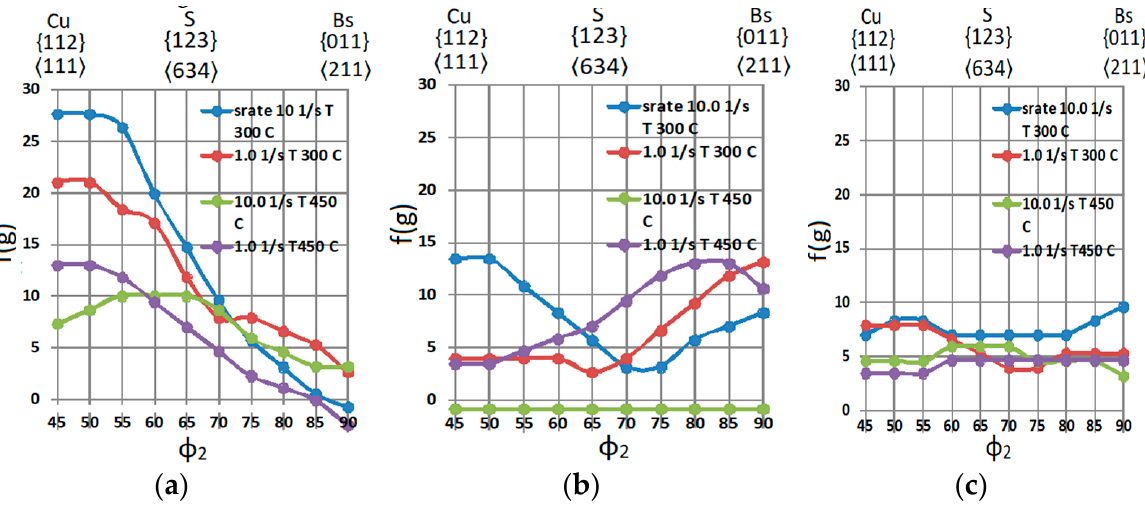
Figure 8. Texture components’ intensities along the β -fiber: ( a ) Aluminum Al-99.5 (AA1050); ( b ) Al-Mg1; ( c ) Al-Mg4.